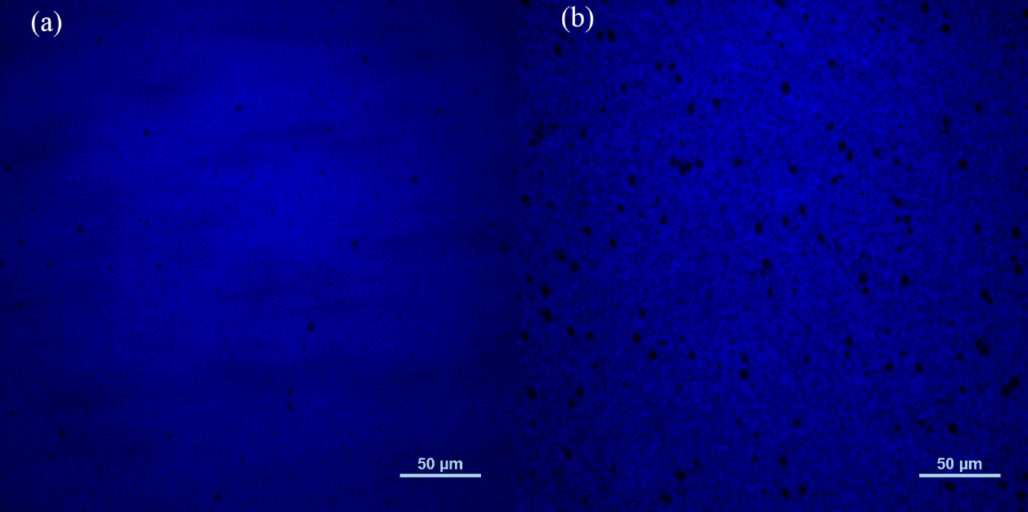
Figure 7. Comparison of µ -PL results between sample A ( a ) and B ( b